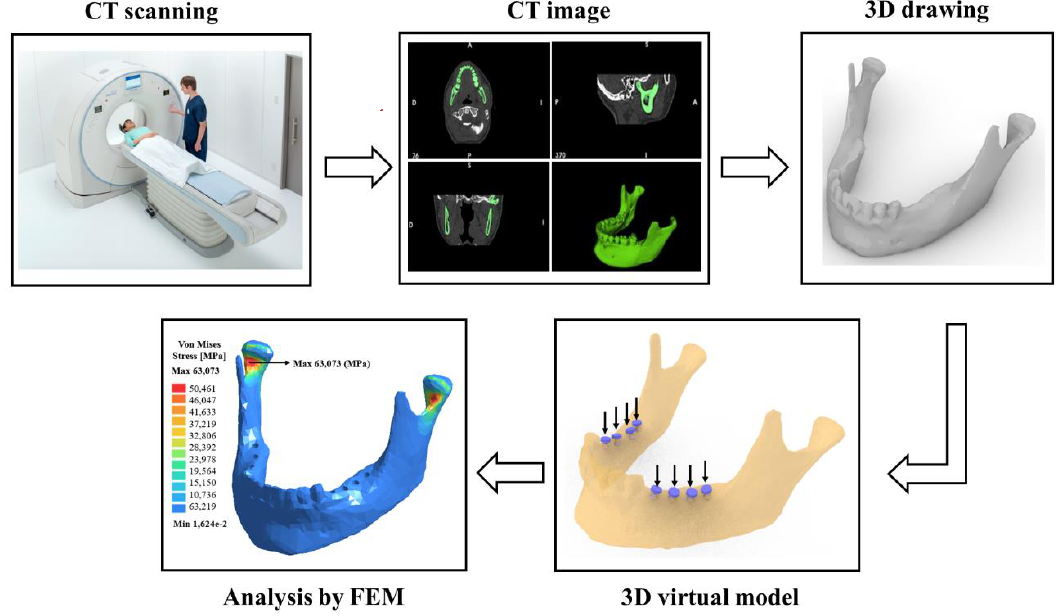
Figure 1. The sequence of the steps involved to use 3D maxillofacial images from the computed tomography scan, and the application of the finite element method (FEM)-based stress analysis.